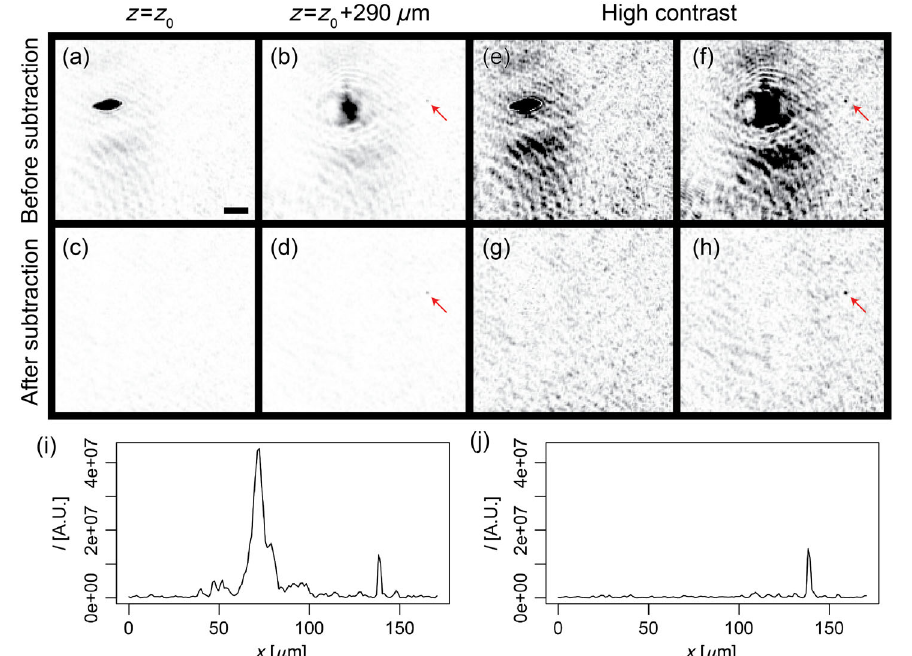
FIG. 8. Signal subtraction detail. (a) Focal plane of reconstructed T. thermophila , to the upper left. (b) Same T. thermophila from (a), 290 μ m out of focus. An E. coli , indicated by a red arrow, is barely visible, to the right — see (f) and (h) for better visibility at high contrast. (c) Focal plane from (a), after the signal from the T. thermophila has been subtracted. (d) Focal plane from (b), after signal subtraction, showing unperturbed E. coli . (e) – (h) Duplicate panels (a) – (d) at high contrast. The scale bar is 20 μ m. (i) Intensity profile across the horizontal coordinate in (b) and (f), through the E. coli cell, before subtraction. The large high-intensity region around 70 μ m is the out-of-focus T. thermophila , while the peak at 140 μ m is the in-focus E. coli cell. (j) Intensity profile through the same row of pixels as in (i), after signal subtraction — see (d) and (h).